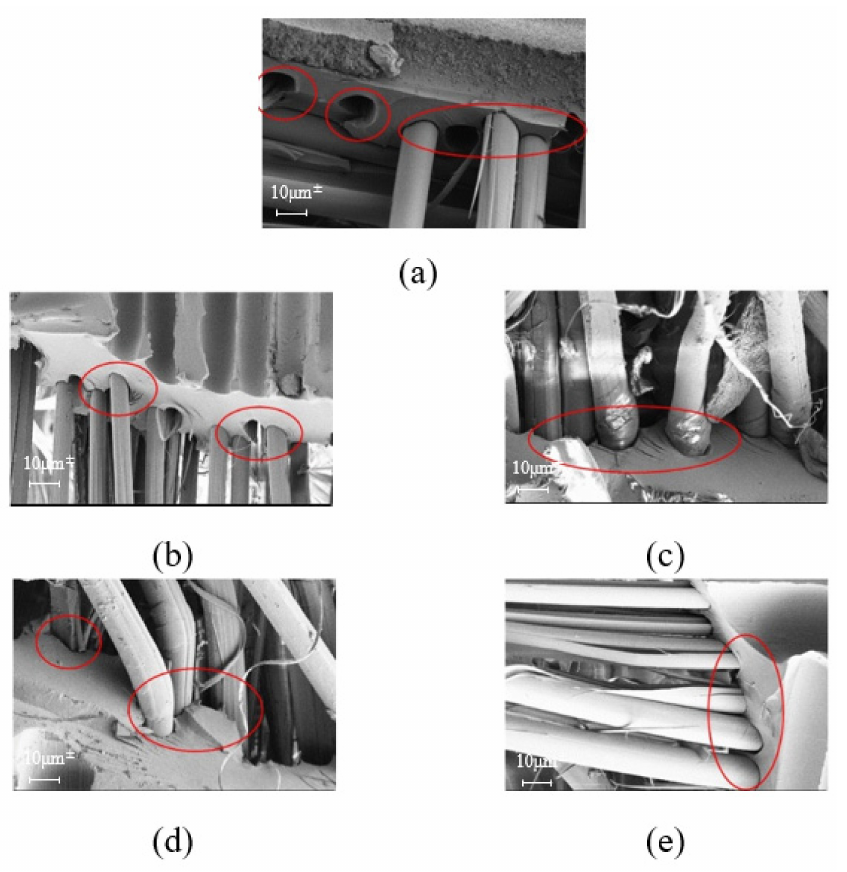
Figure 12. Fracture surface of each composites after the Impact test. ( a ) Untreated, ( b ) 6 wt% ZnCl 2 , ( c ) 6 wt% ZnCl 2 PDA, ( d ) 6 wt% PDA ZnCl 2 , ( e ) 10 wt% ZnCl 2